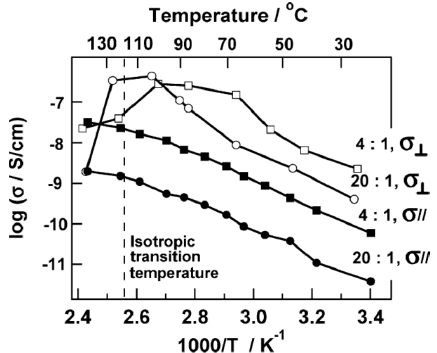
Figure 7. Anisotropic ion conductivity of PEO 114 - b -PMA(Az) 47 –LiCF 3 SO 3 complexes plotted